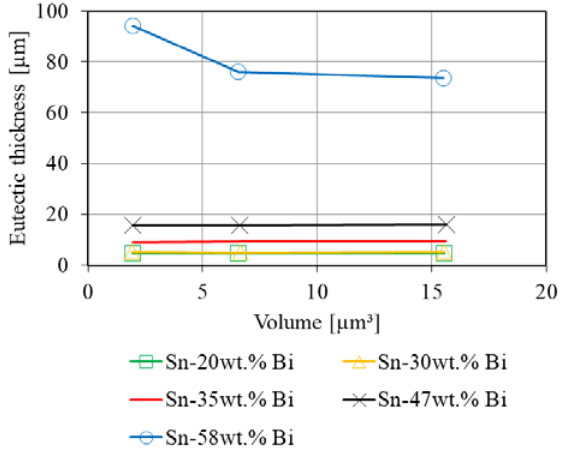
Figure A5. Eutectic thickness over variation of VOI and alloy composition. Figure A5 Figure A5